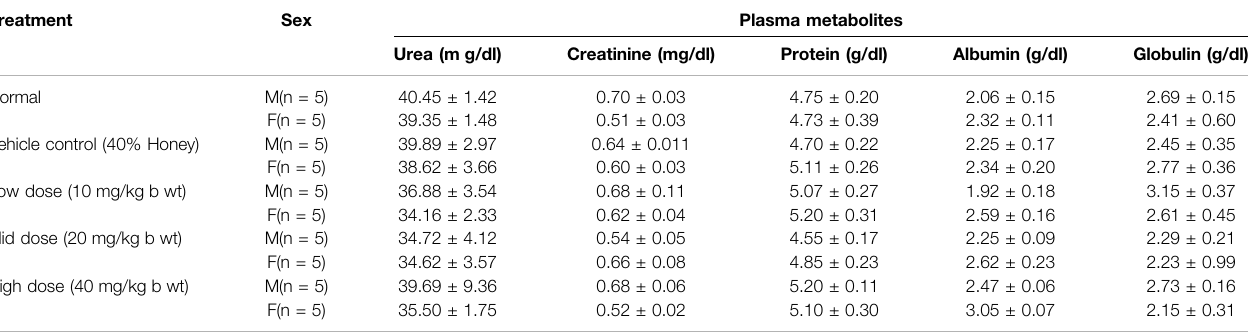
TABLE 6 | Effect of in-house Thamira parpam on 28th day: Biochemical Parameters (Metabolites). Treatment Sex